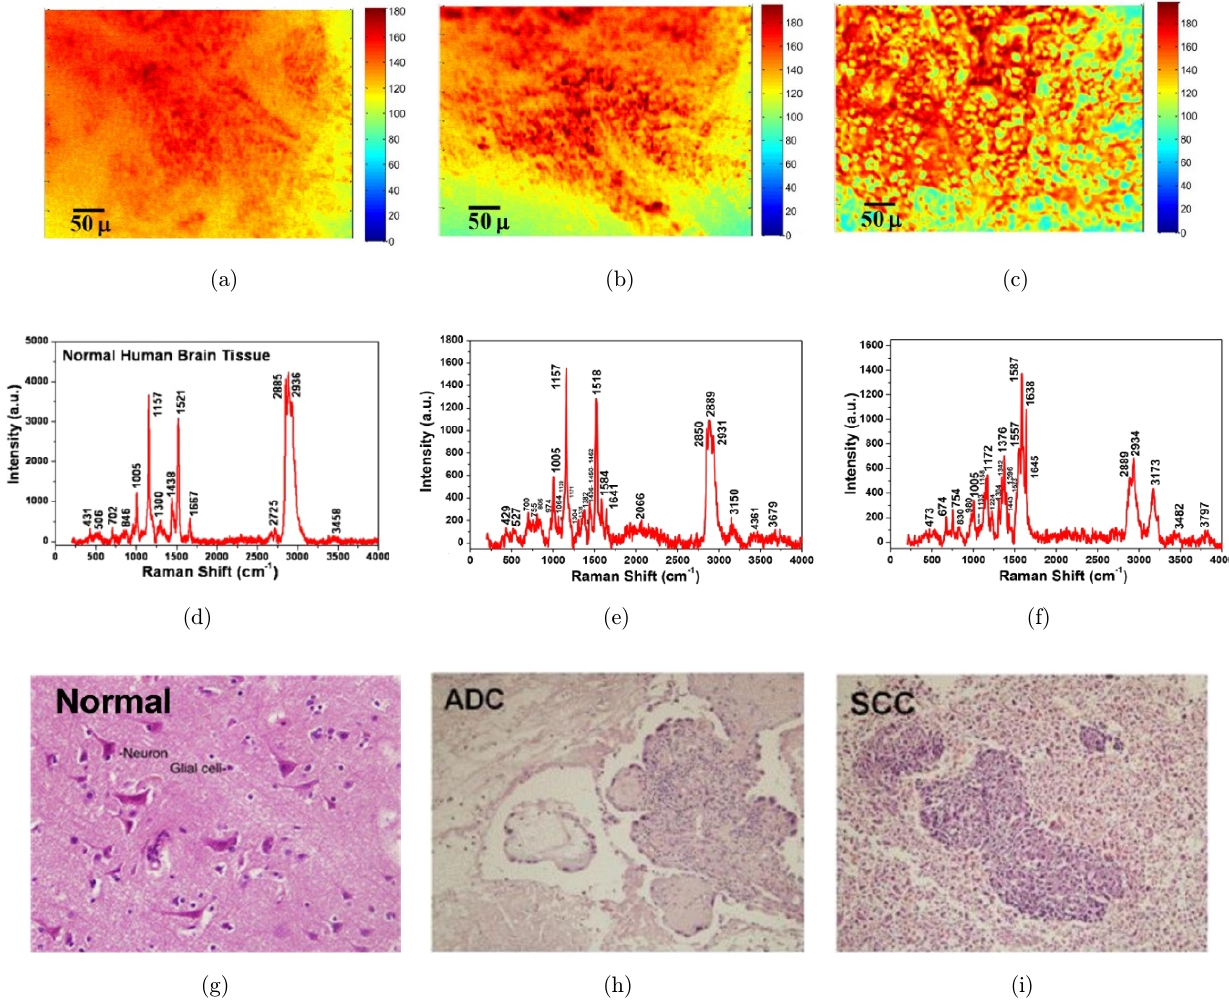
Fig. 1. Three sets of data from brain metastases of lung cancer and normal tissue. Upper row: A set of typical cropped confocal micrograph images using pseudo color of (a) normal brain tissue, (b) brain metastasis from ADC, and (c) brain metastasis from SCC. Middle row: A set of RR spectra of (d) normal brain tissue, (e) brain metastasis from ADC and (f) brain metastasis from SCC. The spectra in (d) – (f) are corresponding to the images in (a) – (c), respectively. Bottom row: H&E-stained images from (g) normal brain tissue, (h) brain metastasis from ADC and (i) brain metastasis from SCC. All the H&E images used 20 (cid:1) objective and correspond to the images in (a) – (c),